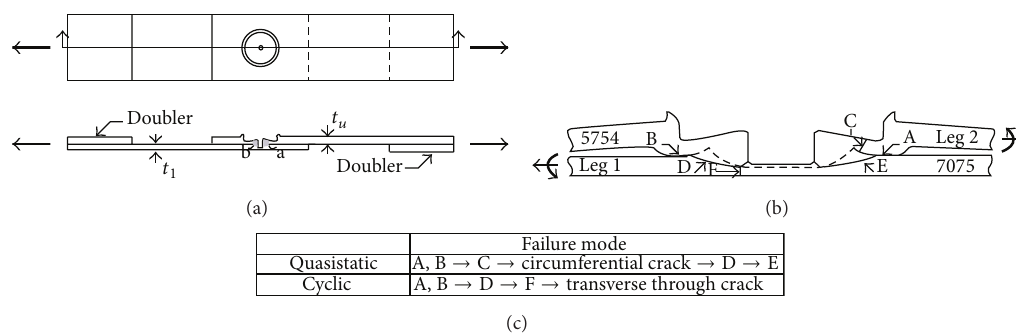
Figure 10: (a) Schematic plots of a spot friction weld in a lap-shear specimen under applied resultant loads (shown as the bold arrows), (b) a schematic plot of the cross-section along the symmetry plane of a 5754-7075 weld in a lap-shear specimen, and (c) failure modes of the 5754-7075 welds in lap-shear specimens under quasistatic and cyclic loading conditions [59].